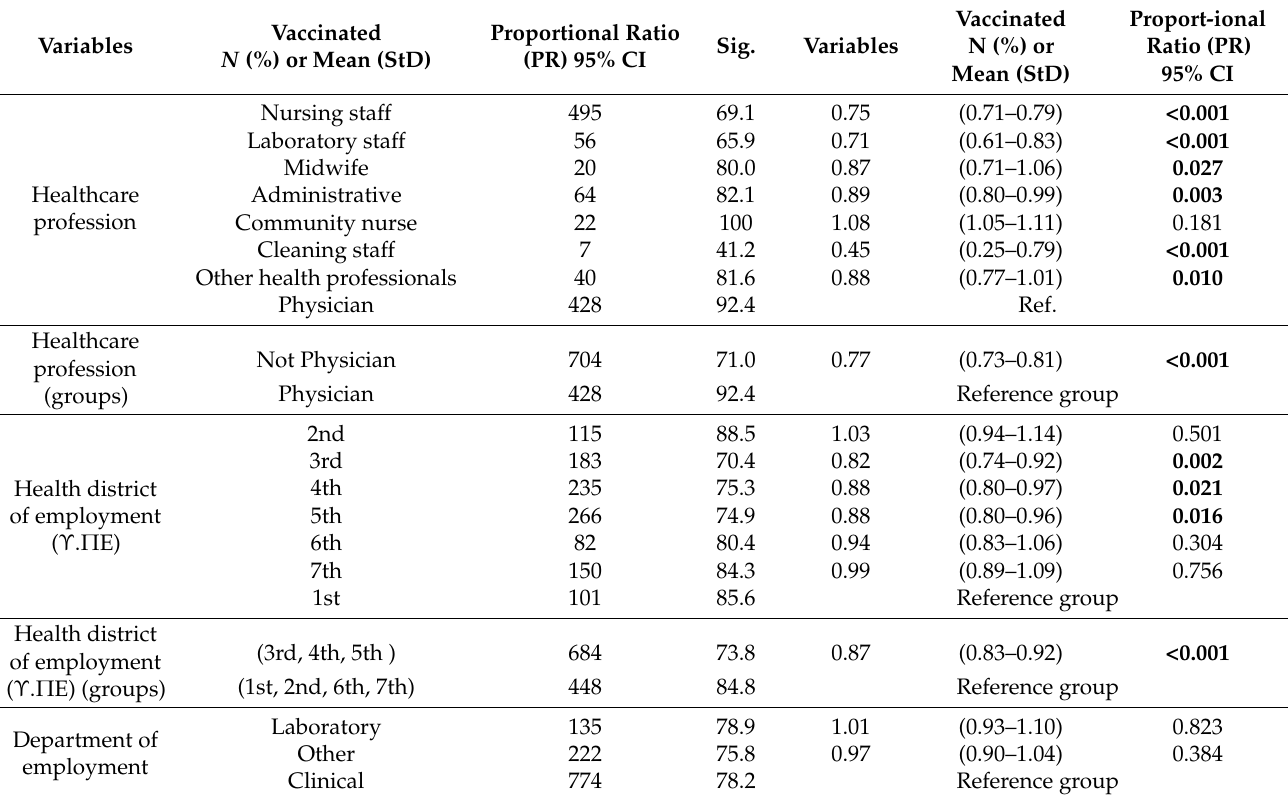
Table 2. Profession characteristics (profession, health district of employment ( Υ . Π E), department and section of employment, years of practice) associated with COVID-19 vaccine acceptance, expressed with proportional ratio in univariate analysis.